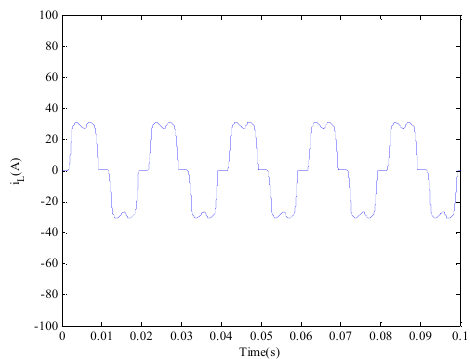
Figure 4. The previous source current of A phase.